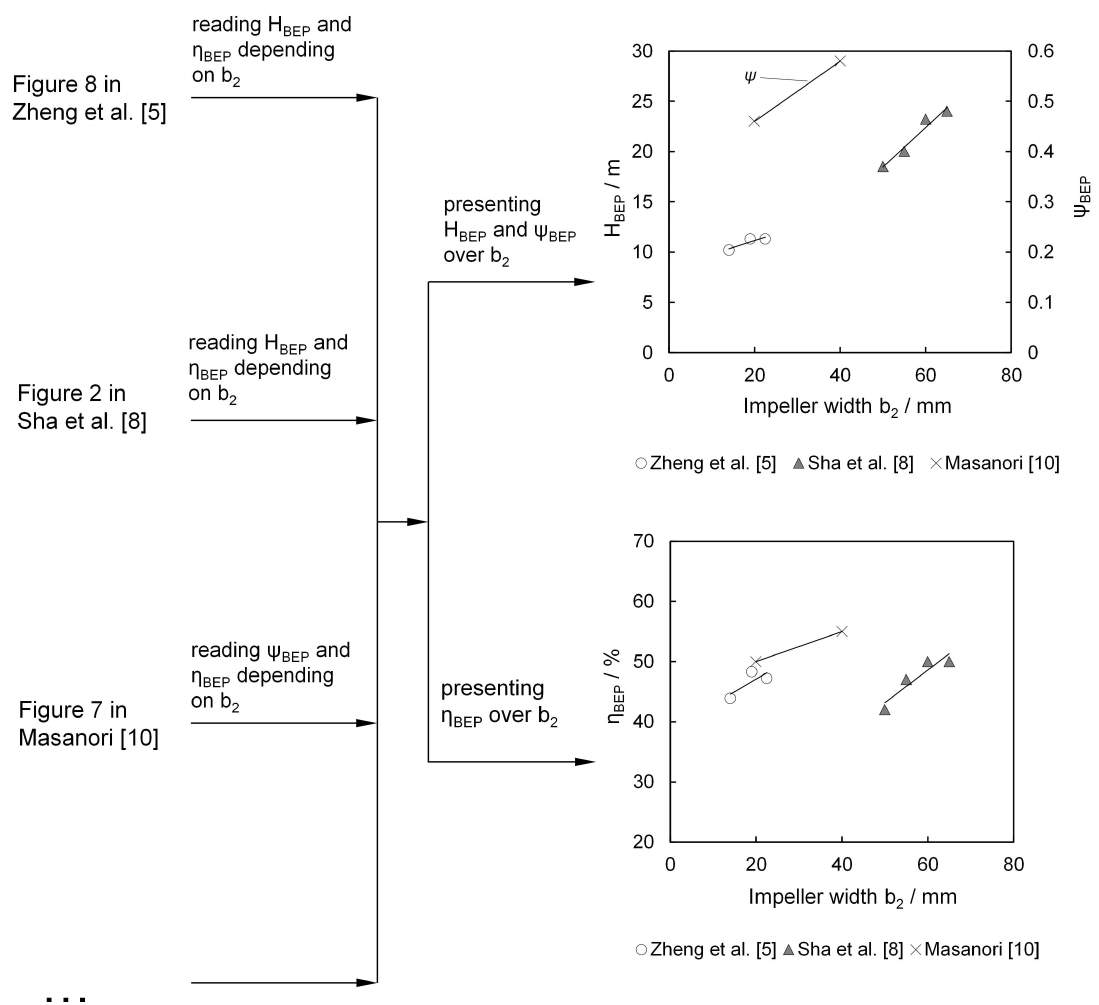
Figure 8. Example for the presentation of the